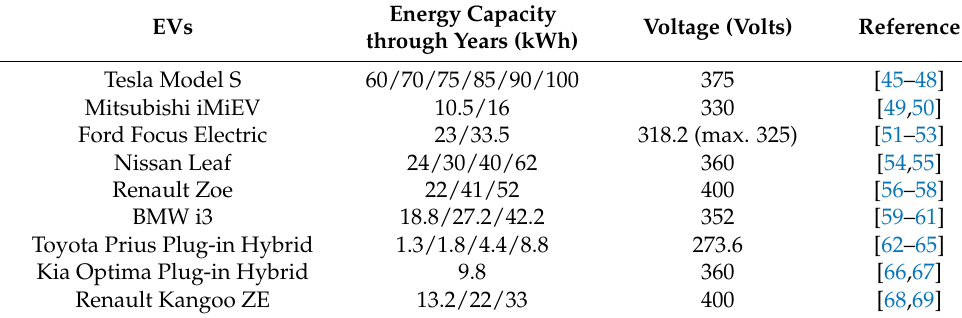
Table 2. Specifications of power batteries in EVs through the